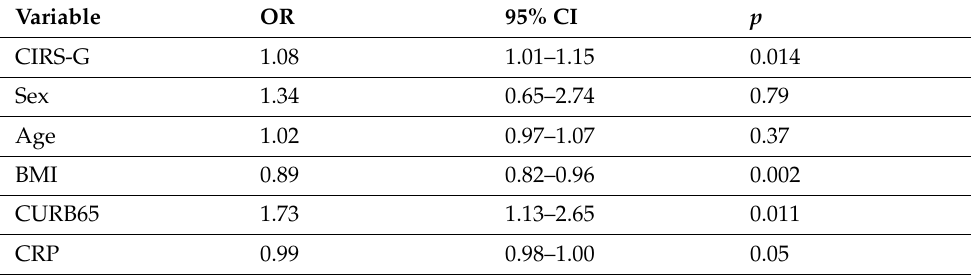
Table A2. Multivariate analysis for 1-year mortality: the CIRS-G value.